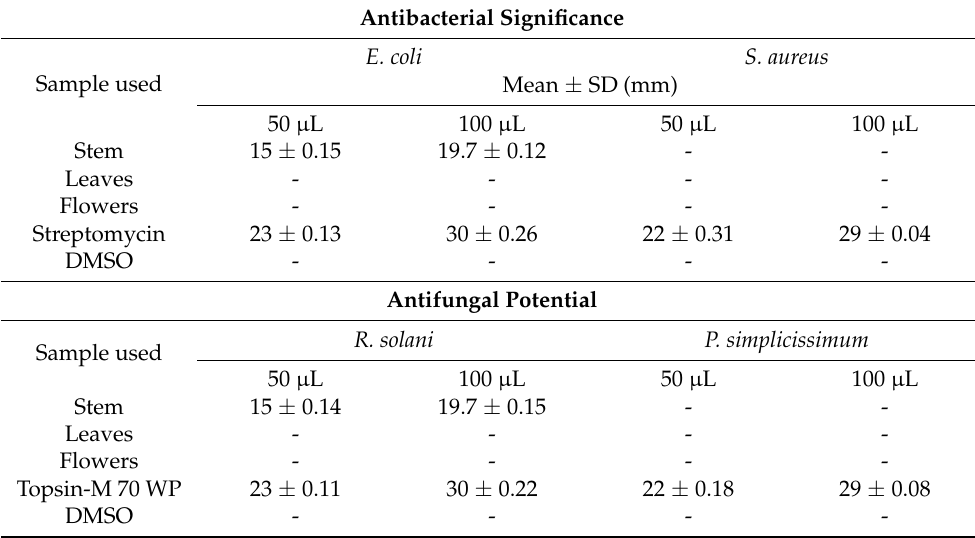
Table 2. Antimicrobial significance of the EOs of O. arabicus